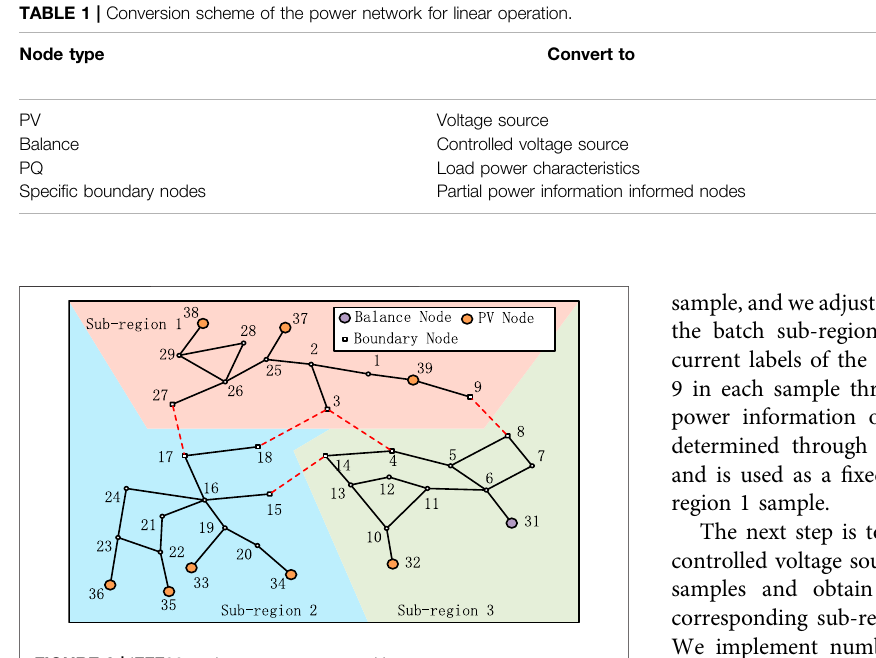
FIGURE 3 | IEEE39 node power system partition